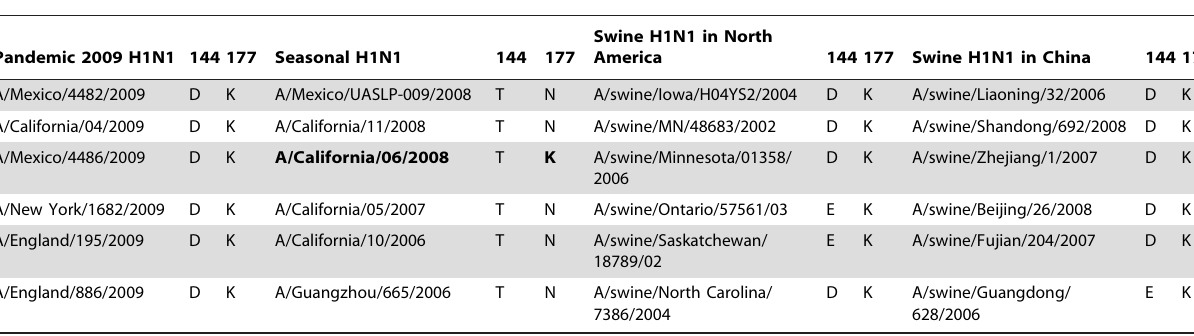
Table 2. The glycosylation sites on HA in different types of A/H1N1 influenza